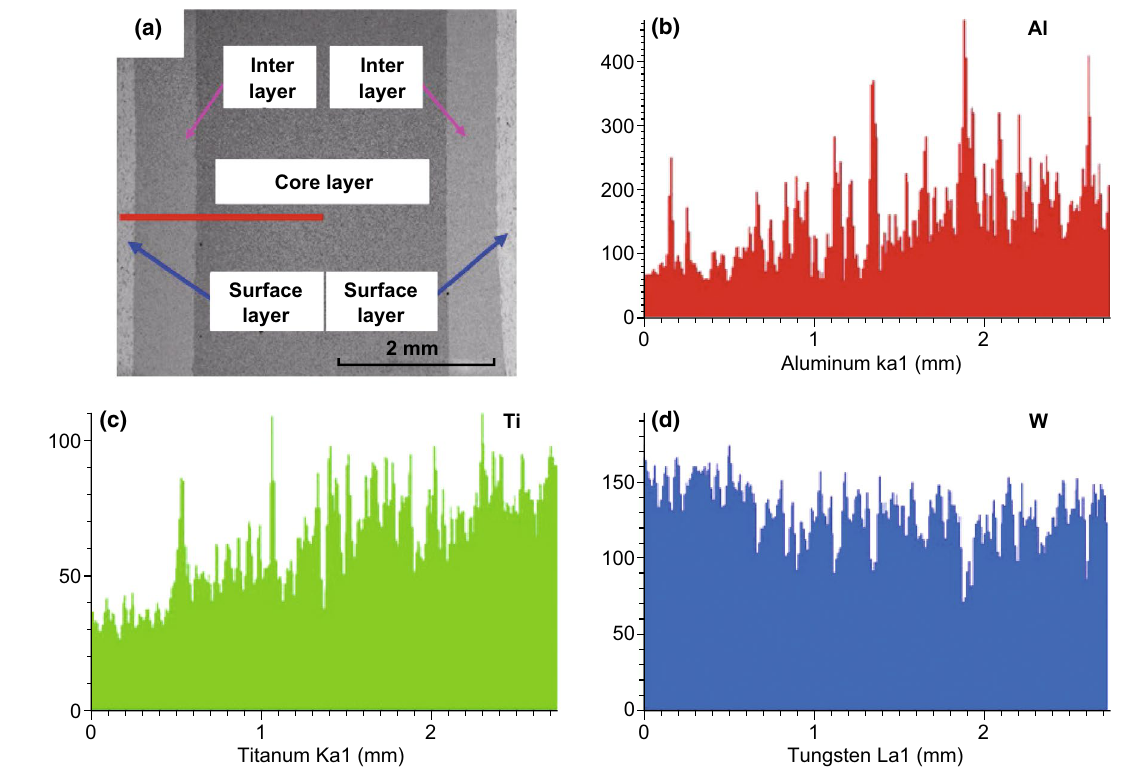
Fig. 13 a SEM micrographs and EDS maps of the distribution of b Al c Ti, and d W elements on the red line of nano‑laminated WC–Al 2 O 3 – TiC ceramics [139]. Figure panels reproduced from Ref. [139] with permission from Elsevier copyright 2017. (Color figure